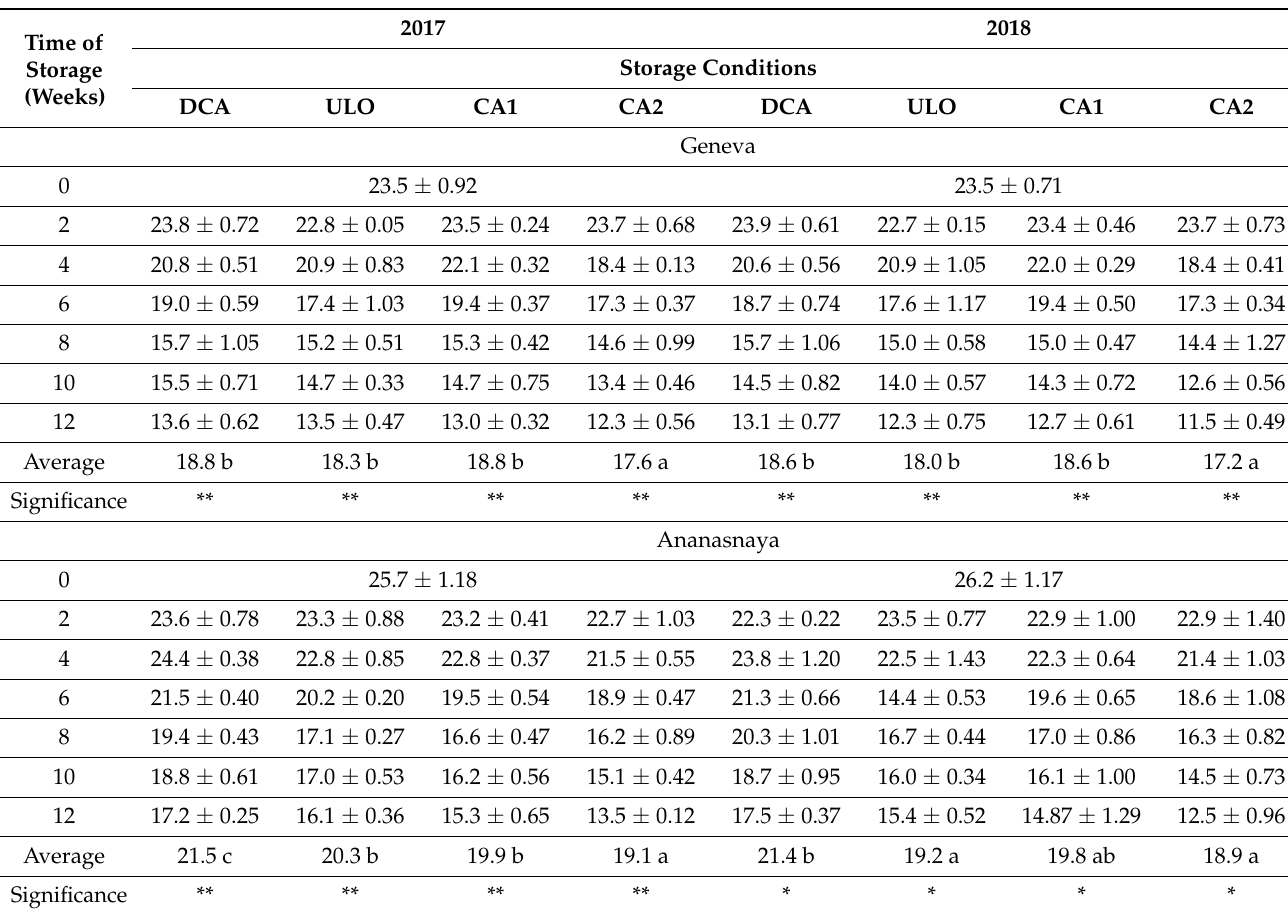
Table 11. Changes in skin color (Chroma) measured in ‘Geneva’ and ‘Ananasnaya’ minikiwi fruits in the postharvest period. Time